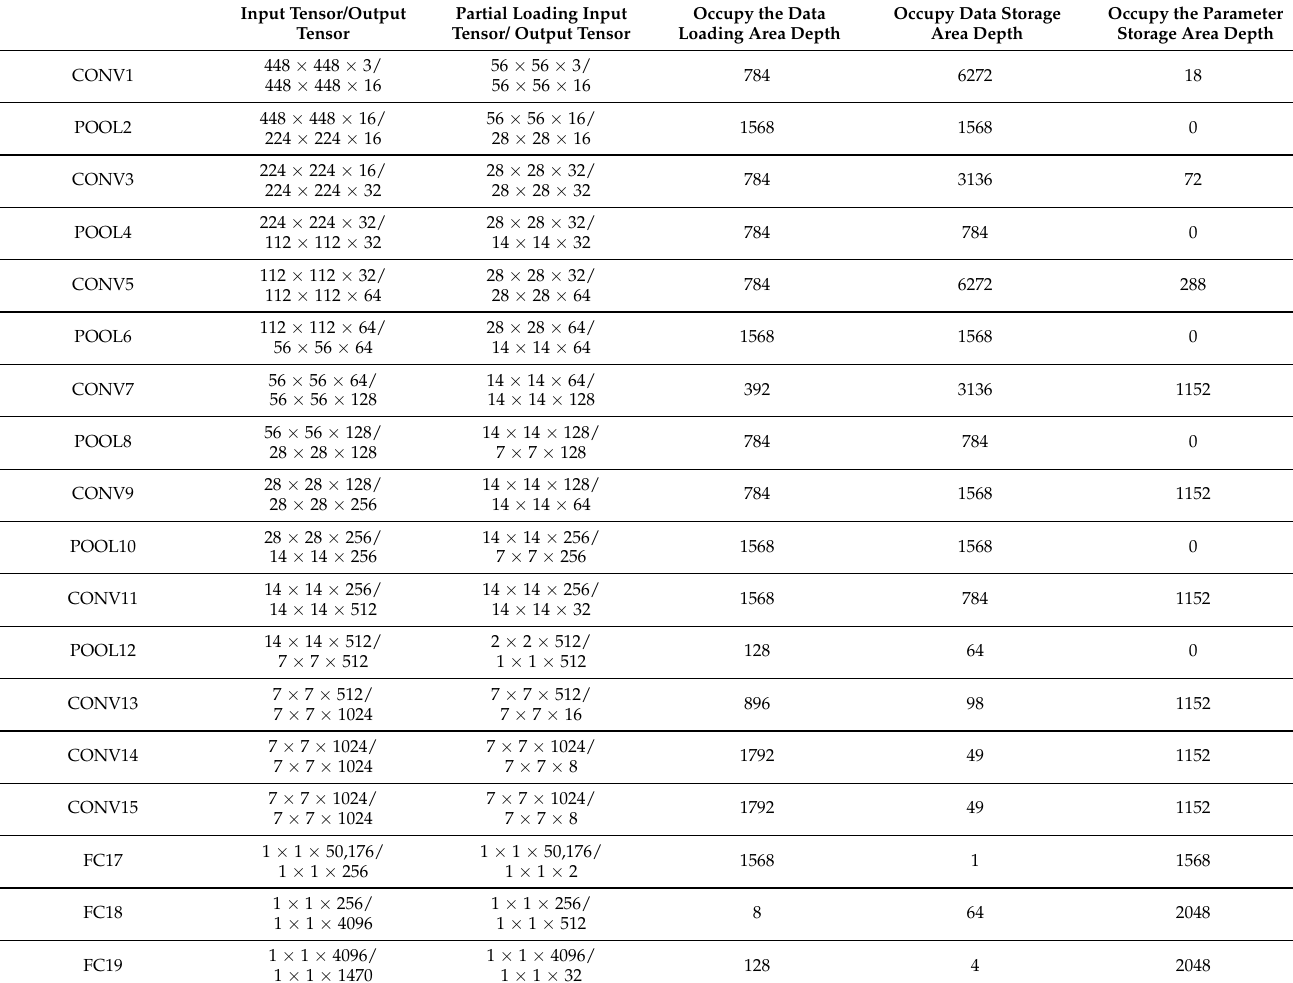
Table 1. TinyYolo loading strategy for each layer